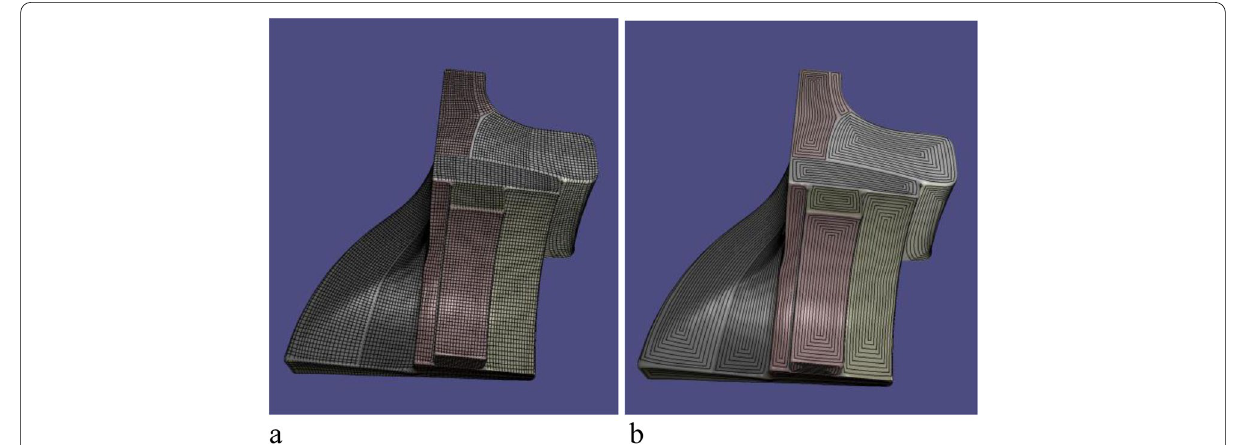
Fig. 16 Whole contour parallel tool paths of Fandisk model. a Grids; b Contour tool paths